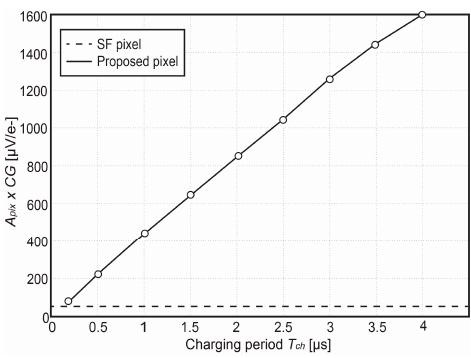
Figure 11. Measured conversion gain ( CG FD × A pix ) as a function of the charging period T ch . [12].